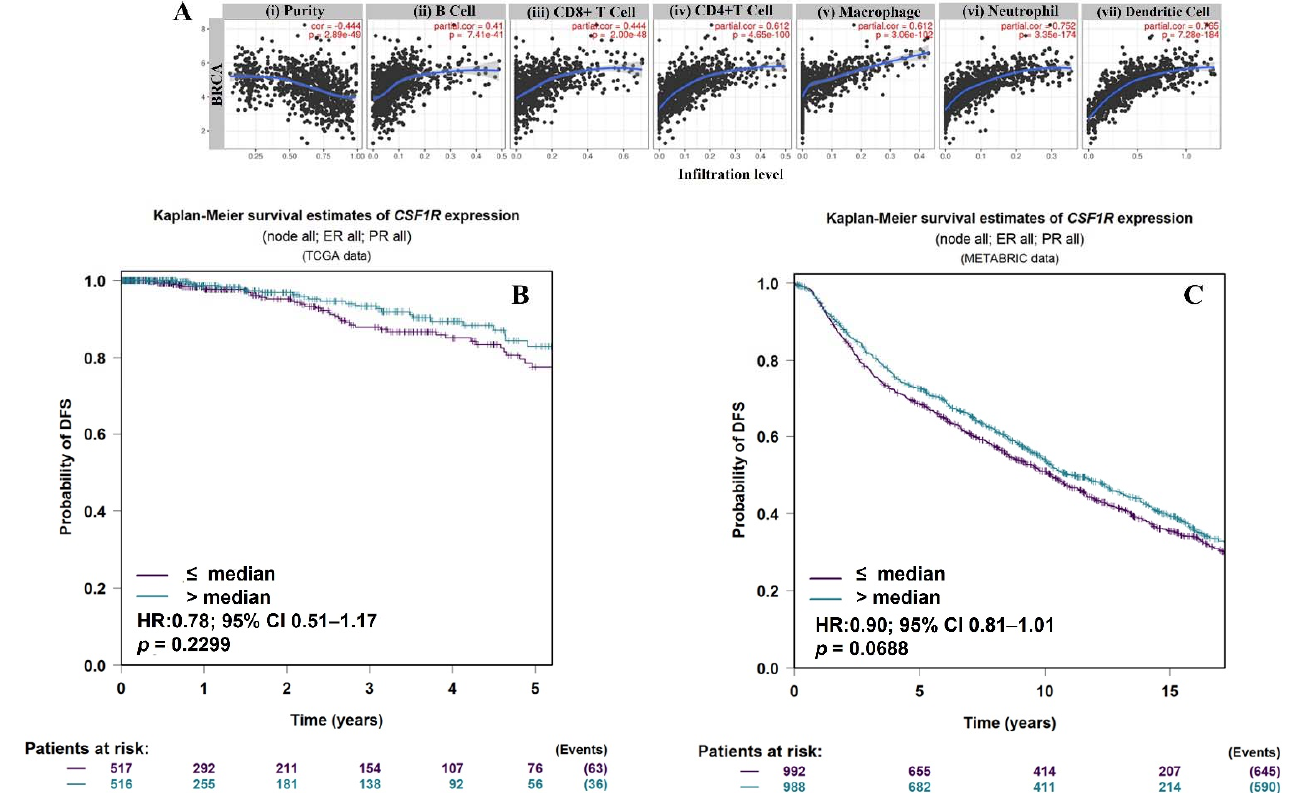
Figure 2. Correlation of CSF1R mRNA expression with immune cell infiltrates and prognosis in breast cancer. TIMER2.0 web server was used to evaluate the correlation between CSF1R mRNA expression and immune cell infiltrates. The left-most panel ( A (i)) shows CSF1R mRNA expression against tumor purity (proportion of cancer cells in the sample), showing a significantly negative correlation. Scatter plots ( A (ii–vii)) show the purity-adjusted partial Spearman’s rho value and statistical significance for positive correlation of CSF1R mRNA with immune cell types (Spearman’s rho: 0, no correlation; 0.1–0.3, weak; 0.4–0.6, moderate; 0.7–0.9, strong; 1, perfect; p -value < 0.05). Five-year Kaplan–Meier curves show an insignificant association of CSF1R mRNA with disease-free survival (DFS) in the TCGA ( B ) and METABRIC ( C ) invasive breast cancer cohorts. The p -value and hazard ratios (HR) with corresponding 95% confidence intervals were estimated by the log-rank test. The survival curves for TCGA and METABRIC cohorts were generated using Breast Cancer Gene-Expression Miner